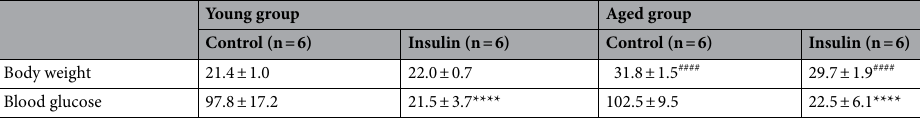
Table 4. Body weight (g) and blood glucose concentration (mg/dl) in brain 18 F-FDG autoradiography study. Data are shown in parentheses (mean ± SD). Control, control group; Insulin, insulin-loaded group. **** P < 0.0001 vs control value. # ### P < 0.0001 vs young groups in control and insulin-loaded groups.